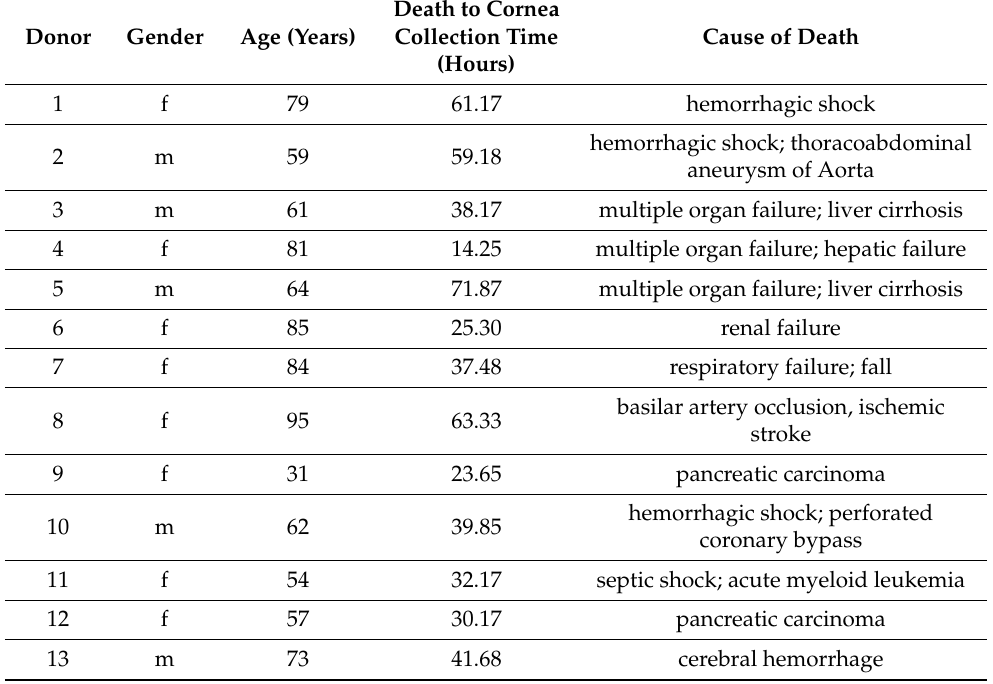
Table 1. Gender, age, death to cornea collection time and cause of death of the cornea donors included in this